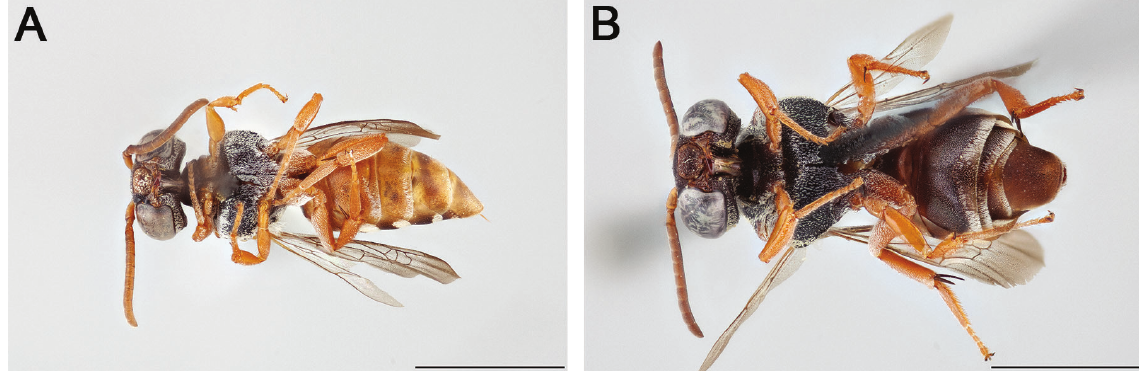
Fig. 26. Epeolus spp., habitus of female, ventral view. A . E. basili Onuferko, 2018, paratype showing antennae, legs, and metasomal sterna with similar reddish-orange coloration. B . E. pusillus Cresson, 1864 showing color contrast between reddish-orange legs and dark brown antennae and metasomal sterna. Scale bars = 3